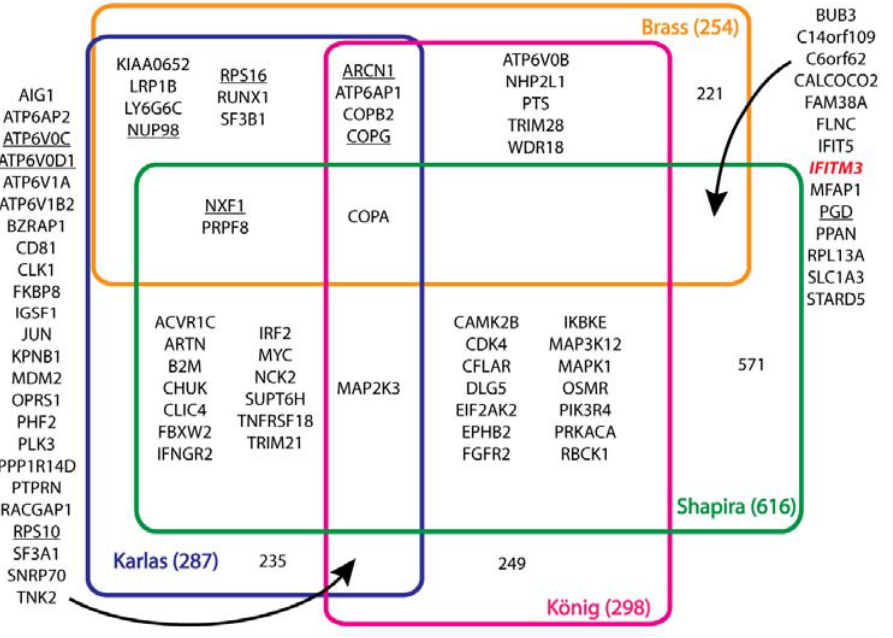
Figure 1. Identification of host proteins that regulate influenza virus replication in multiple screens. The overlap between different screens for influenza virus host factors is shown as a Venn diagram. Total genes for each screen and the number of genes unique to each screen are indicated. Note that each screen utilized different criteria to query and score host genes as regulators of virus infection. Genes found by Hao et al. [4] with obvious human homologues are